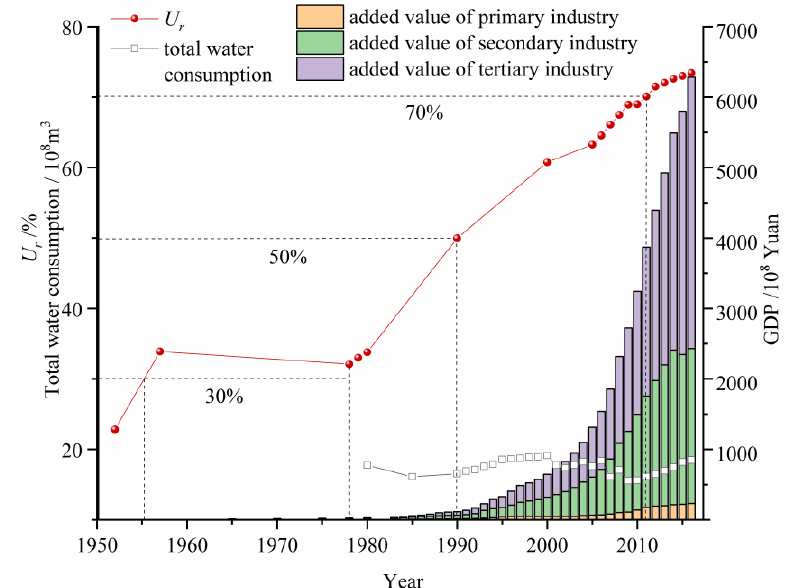
Figure 3. The variations of urbanization rate ( U r ), total water consumption, added value of three industries, and gross domestic product (GDP) of Xi’an over time. GDP is the sum of three industrial added values; the data of total water consumption are from 1980 to 2016. The red line represents the U r value from 1952–2016, and the white line represents the total water consumption from 1980–2016.